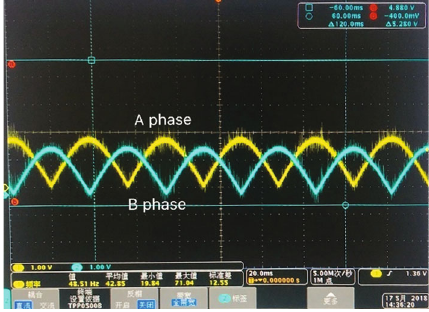
Figure 15: Current wave of stepping motor two